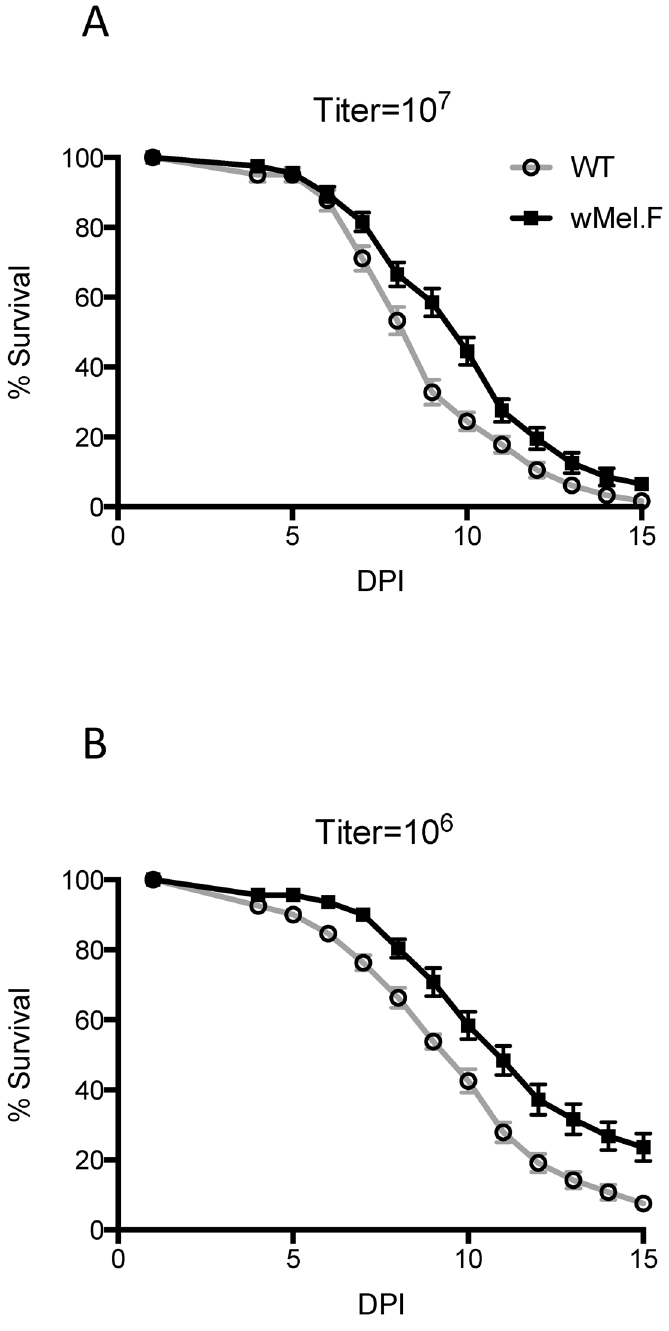
Fig 4. Survival curves of WT (grey line) and w Mel.F mosquitoes (black line) orally infected with either 10 7 (A) or 10 6 (B) PFU/ml of DENV. Bars depict means ±